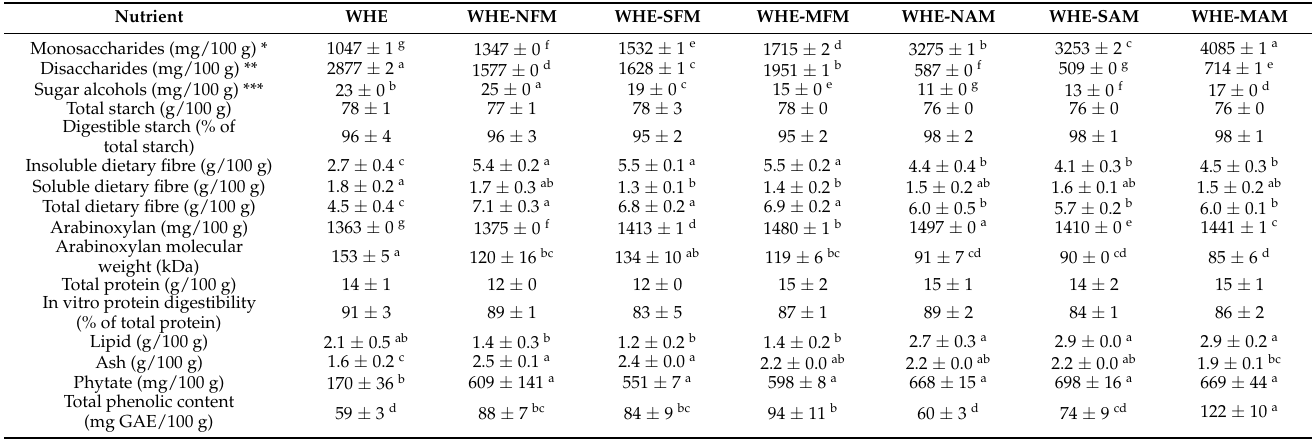
Table 5. Nutrient composition (based on dry weight) and quality of